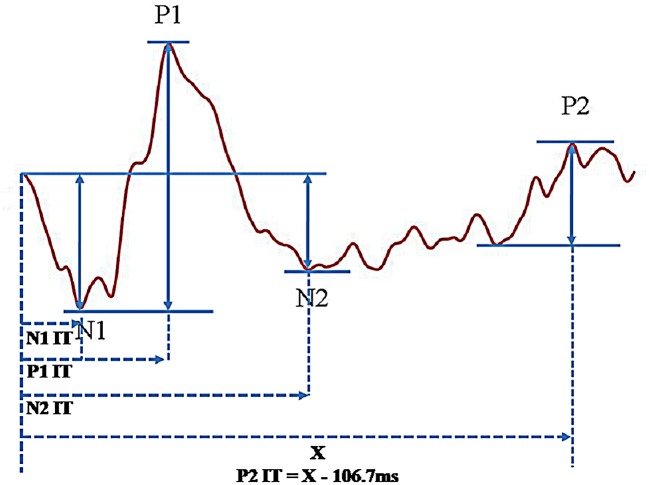
The waveform under the “long-duration” mfERG paradigm showing the parameters measured.